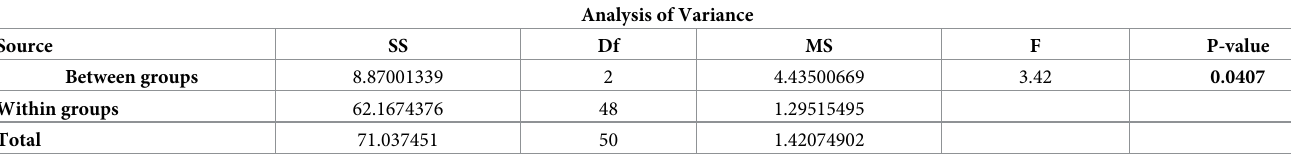
Table 6. Comparison of mean total protein with age categories among cases (One way ANOVA).